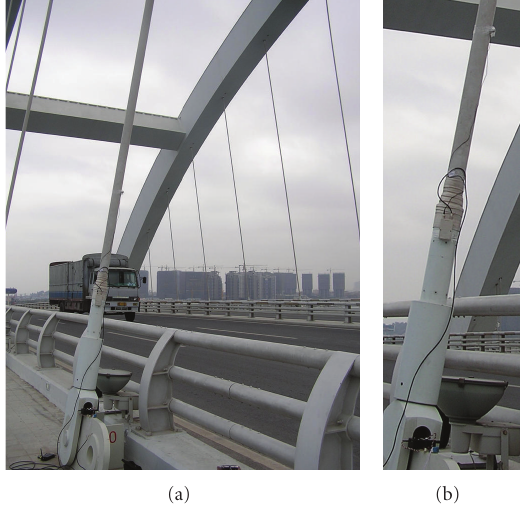
Figure 10: Accelerometer with wireless sensor on a hanger.